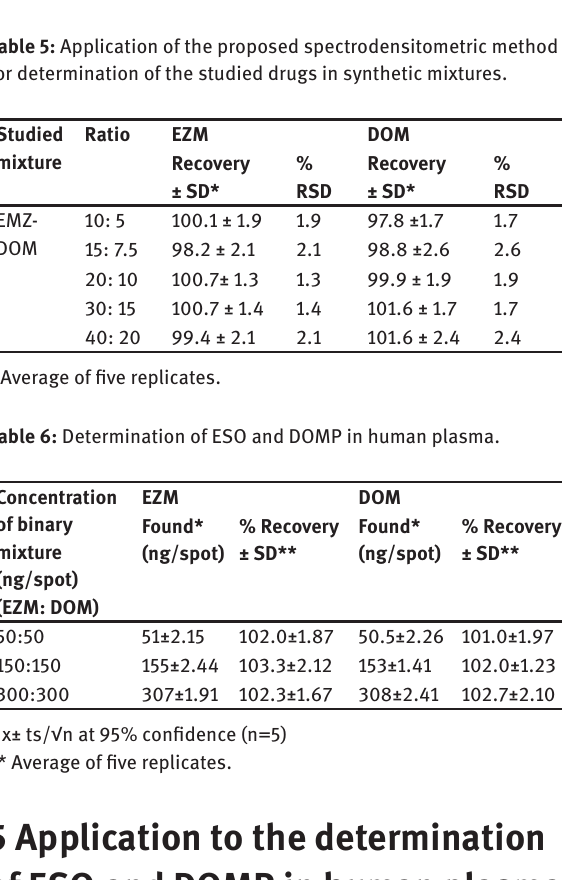
Figure 5: TLC of unspiked plasma (A) and spiked plasma (B).